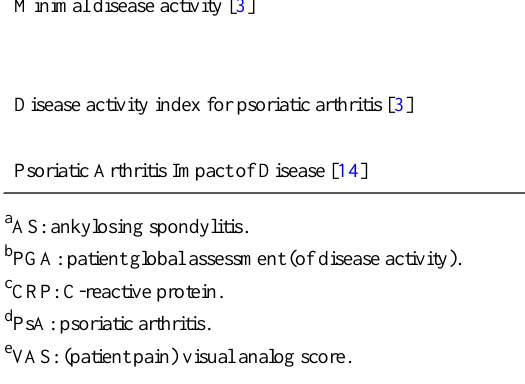
Instrument componentsSpondyloarthritis